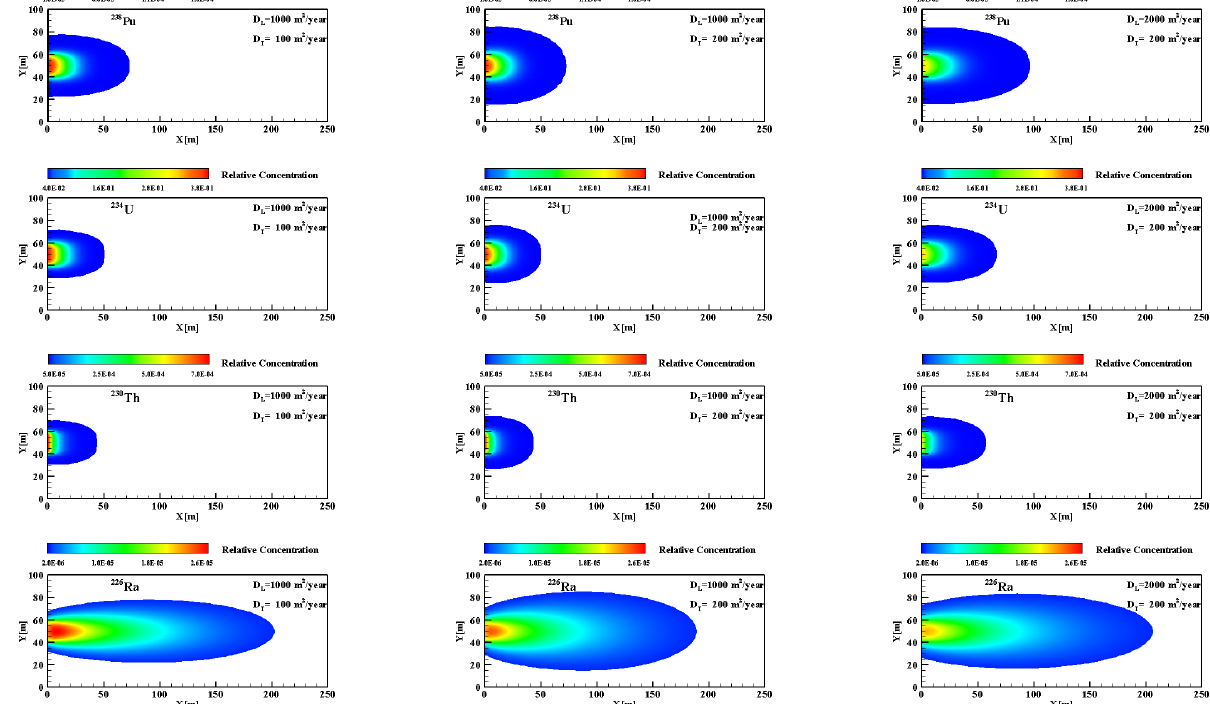
Figure 9. Effects of physical processes and chemical reactions on the concentration contours of four-species at t = 1000years obtained from derived analytical solutions for four-member decay chain 238 Pu → 234 U → 230 Th → 226 Ra.